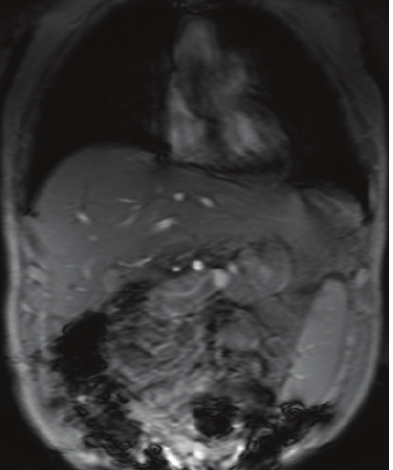
Figure 2: Magnetic resonance of abdomen. Coronal